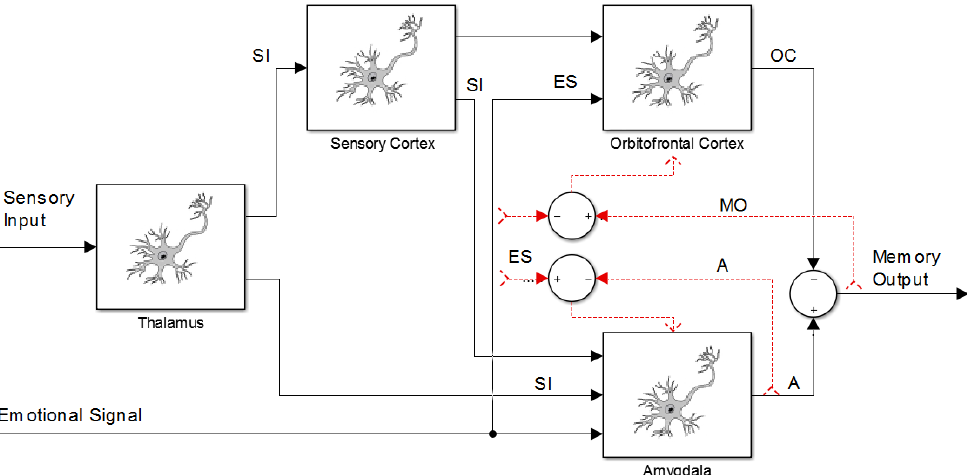
Figure 1. Block diagram of the BEL model (briefly characterized in Section 1.4), proposed by Moren and Balkenius [29], where: SI—sensory input, ES—emotional signal, OC—orbitofrontal cortex, A—amygdala, MO—memory